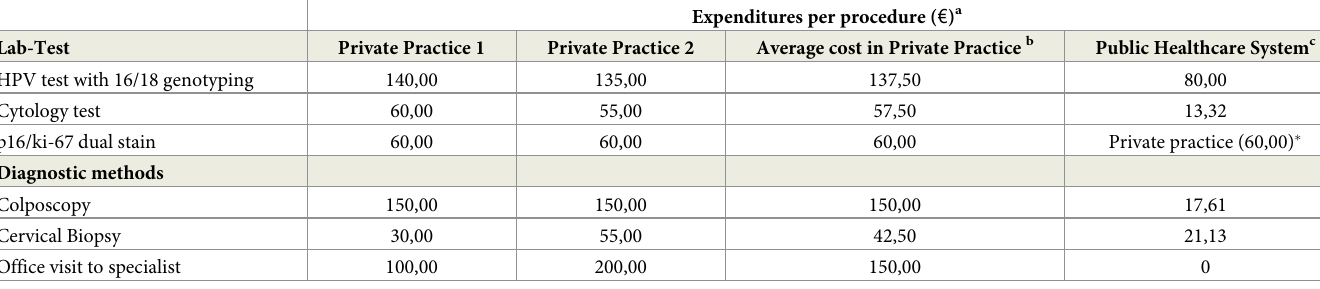
Table 2. Costs of the lab-tests and diagnostic methods for HPV